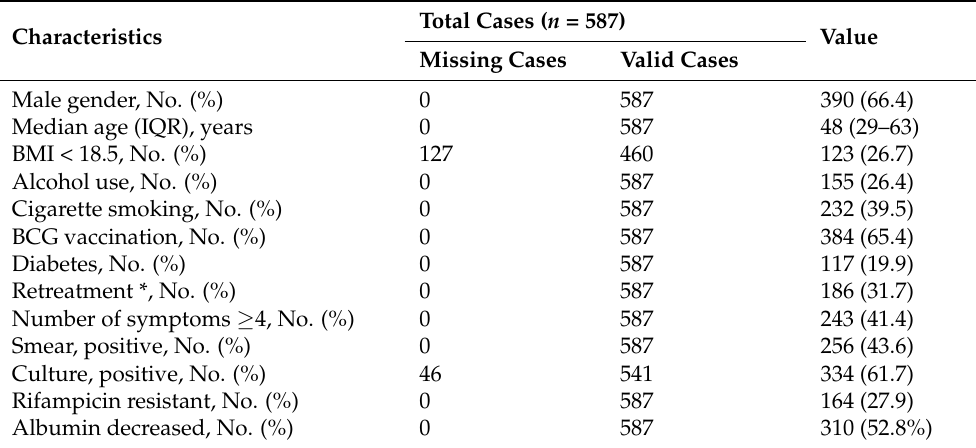
Table 1. Characteristics of the study participants.